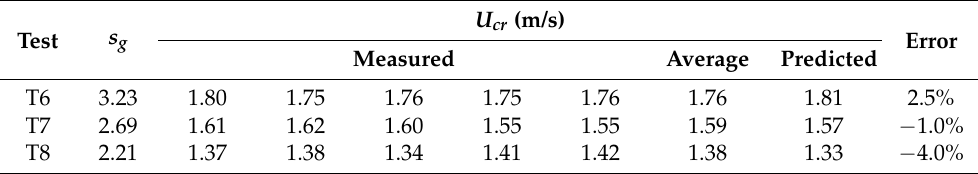
Figure 7. The velocity in Test 6 ( s g = 3.23, µ = 0.25). The critical sliding failure velocity is 1.8 m/s. Table 4. A summary of the measured and predicted critical failure velocity.